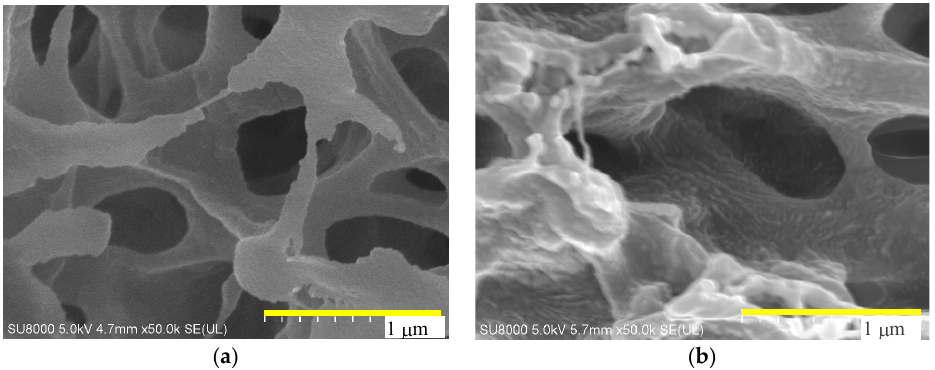
Figure 9. SEM images of membrane cross-sections, magnification 50k: ( a ) Accurel PP S6/2 and ( b ) K1800.